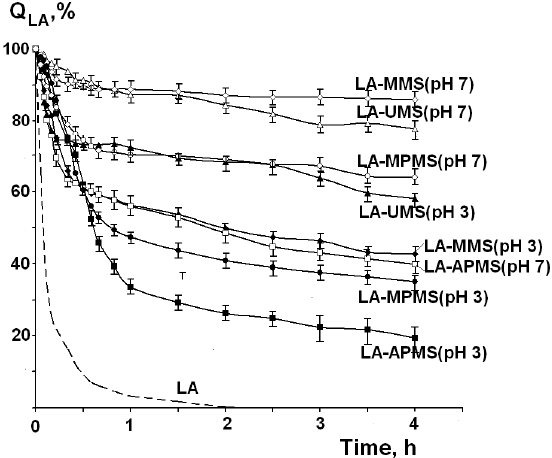
Figure 7. Kinetic curves of thermal degradation of free LA and LA in the composites at temperature 67 ◦ 67 °C.